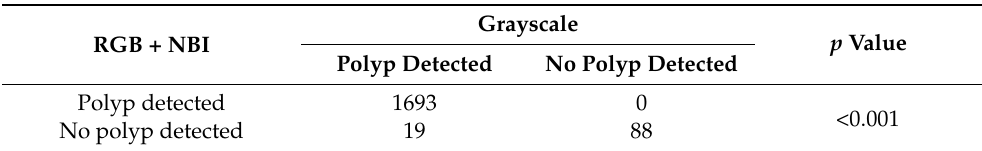
Table 11. Comparison of polyp detection between RGB + NBI and grayscale images with CGMH WL + CGMH-NBI testing dataset.